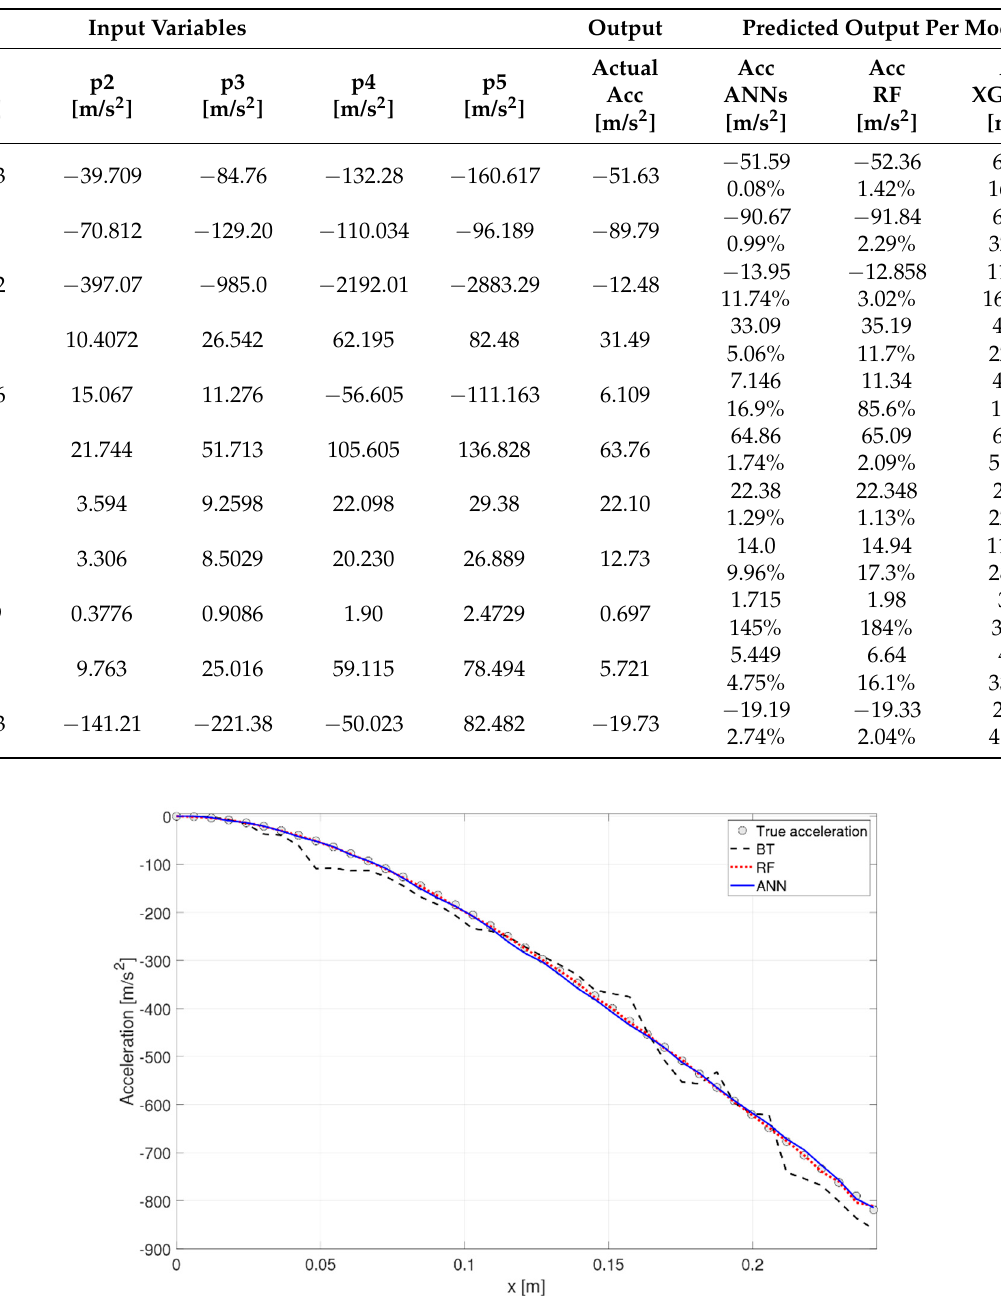
Table 7. Predicted values for acceleration “Acc” for a set of input variables from the test data. The data in the table was randomly selected to show models’ performance.